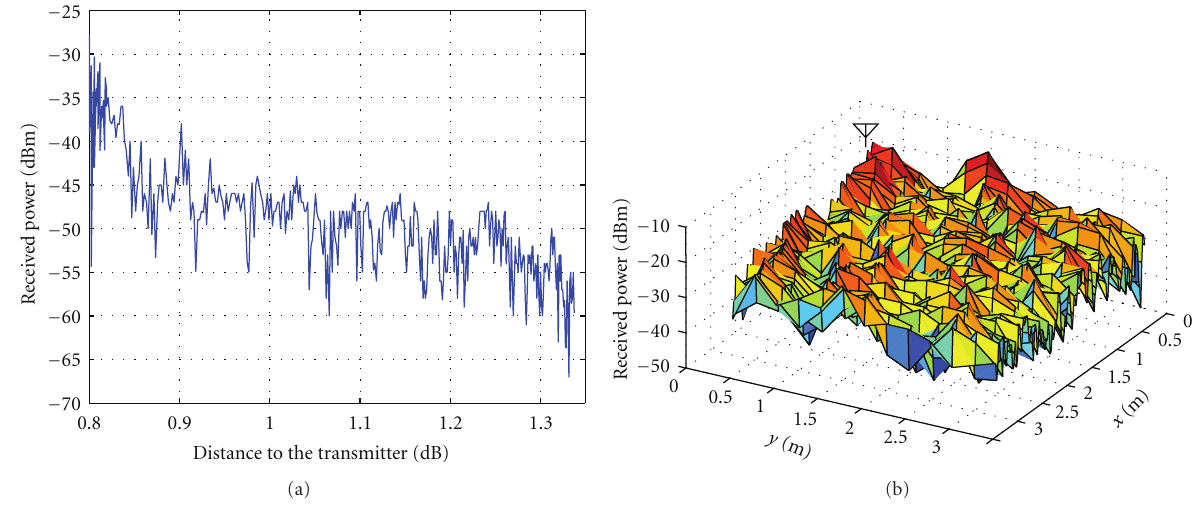
Figure 1: Sample channel measurements in (a) 1D and (b)